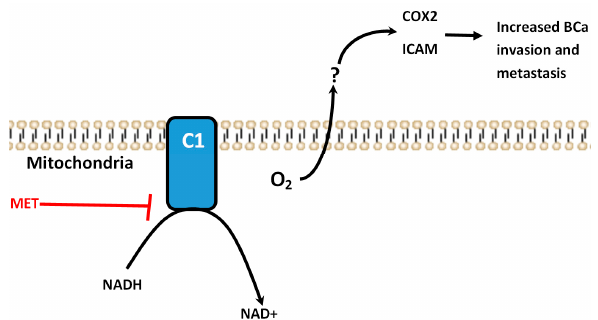
Figure 6. Model for metformin anti-neoplastic activity. In this model, superoxide is generated in cancer cells during mitochondrial respiration as a by-product of NADH reduction in cancer cells. ROS